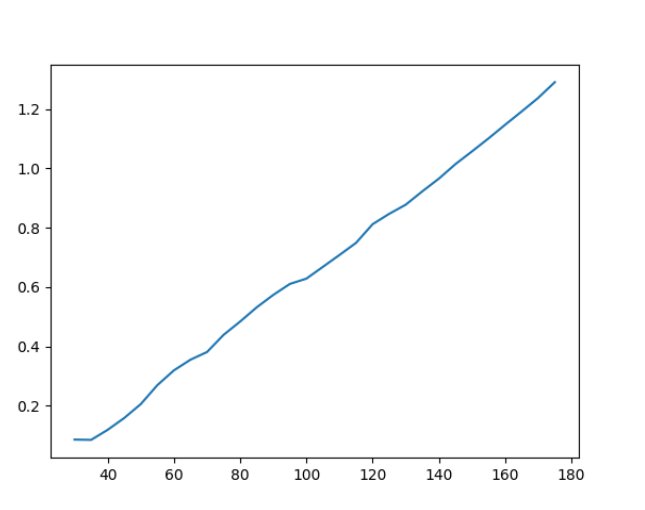
Figure 7. Influence of Gaussian surround scale on time.